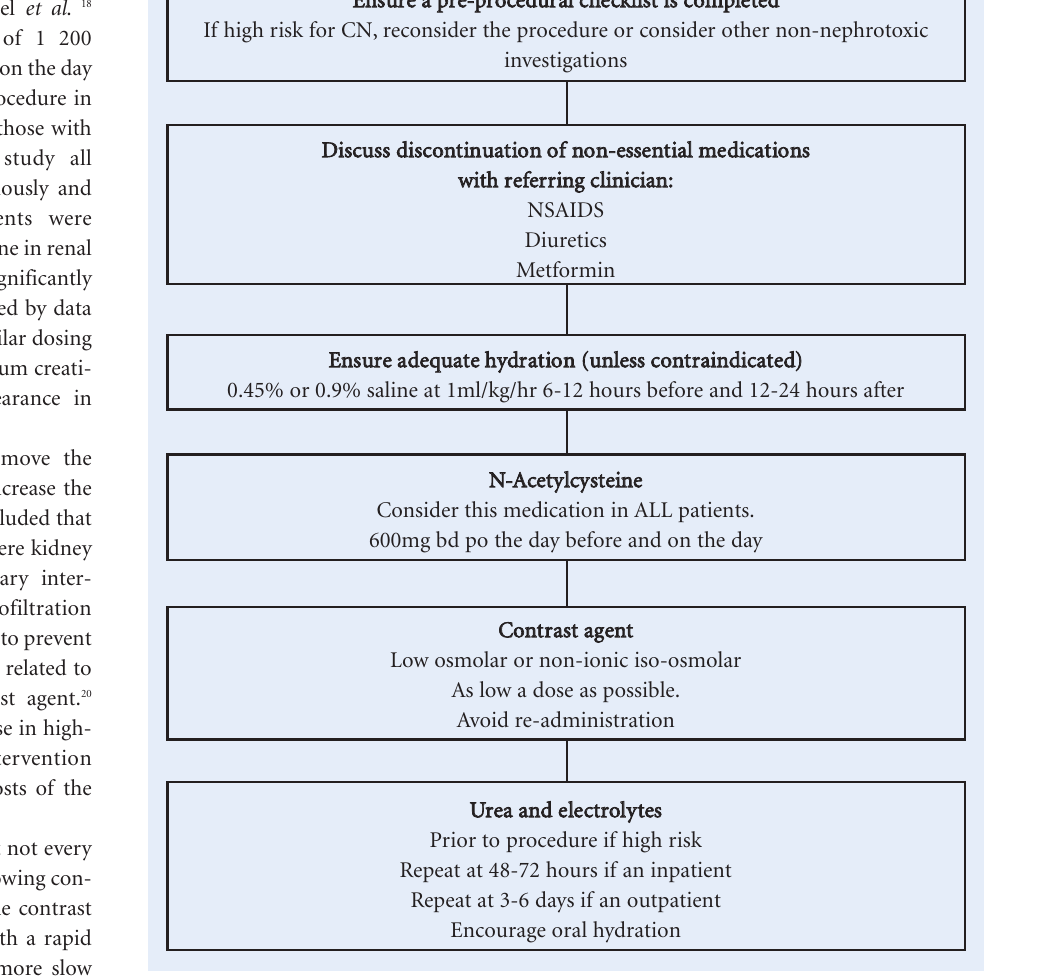
Fig. 1. Recommended peri-procedural methods to prevent contrast